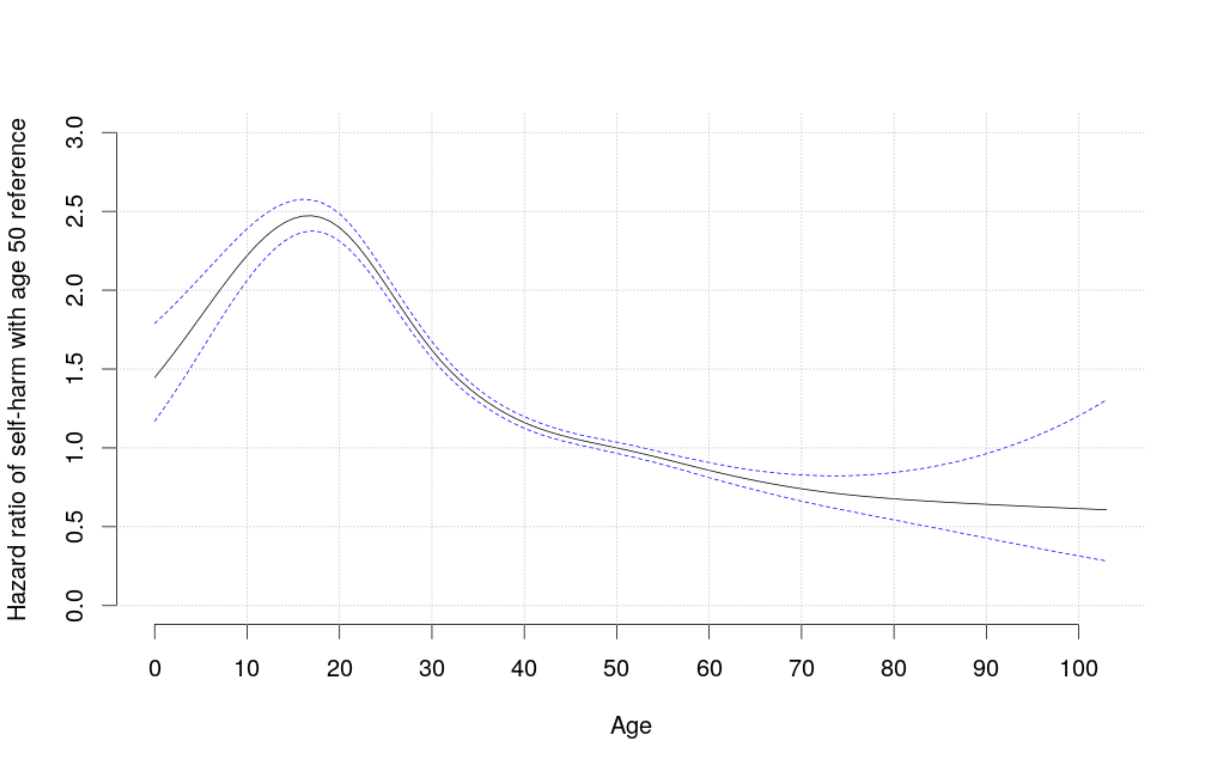
Figure 4. The hazard ratio of coded and/or imputed self-harm as a function of patient age. The graph represents a smoothing spline, with the reference being age 50 years. The blue dotted lines represent 95%